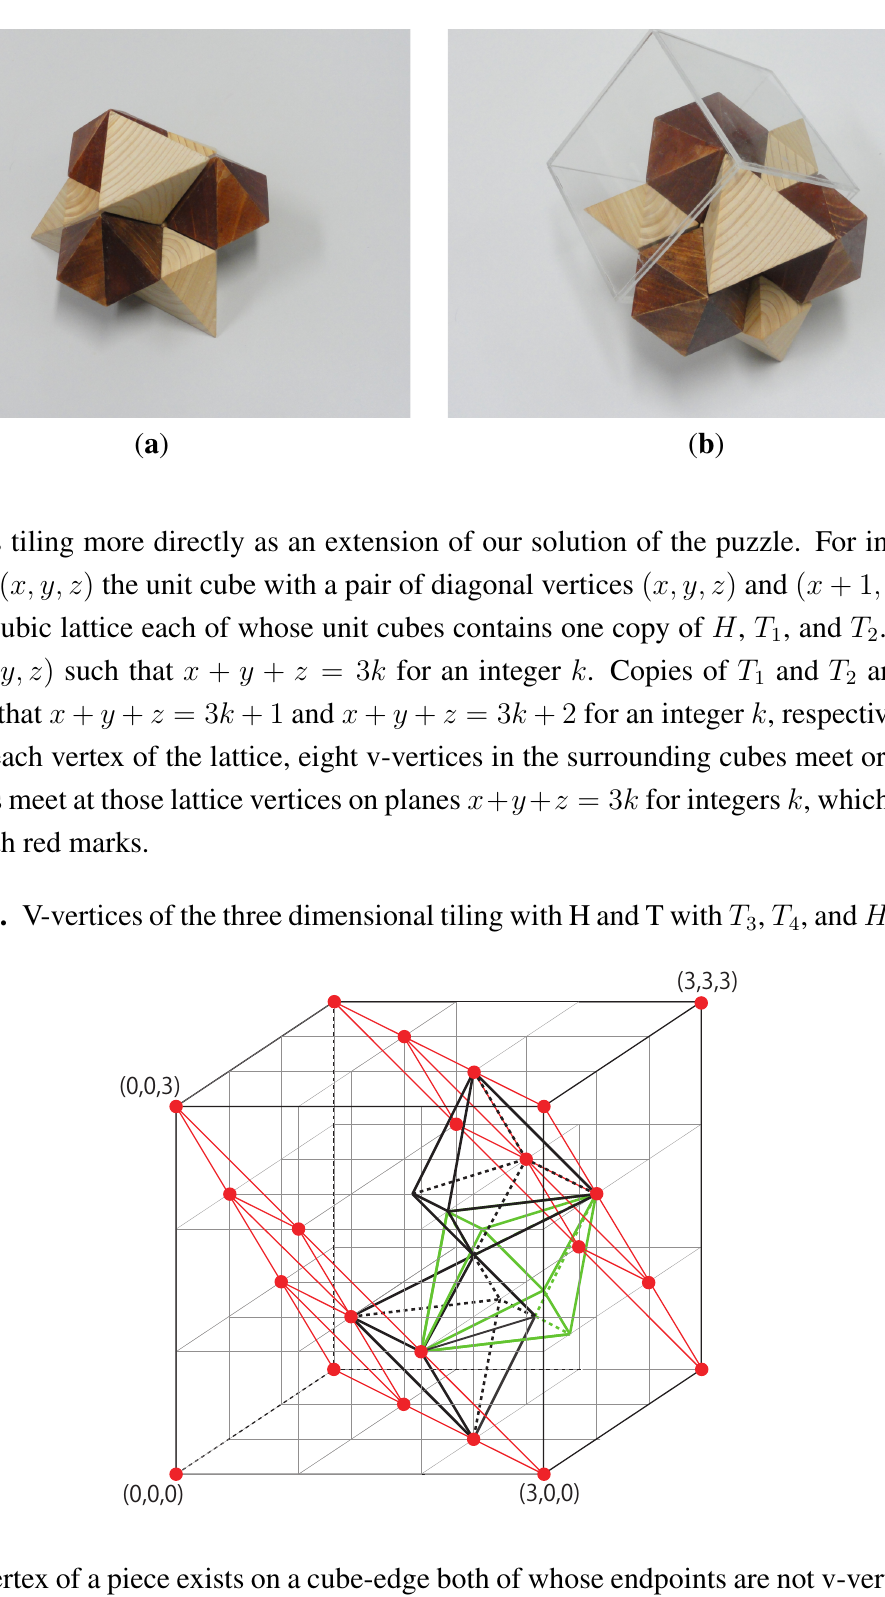
Figure 12. ( a ) Three H and five T pieces are in this picture. We consider a block obtained by adding one more copy of T at the bottom with the same direction as the copy on the top; ( b ) We can put this block into the puzzle box.